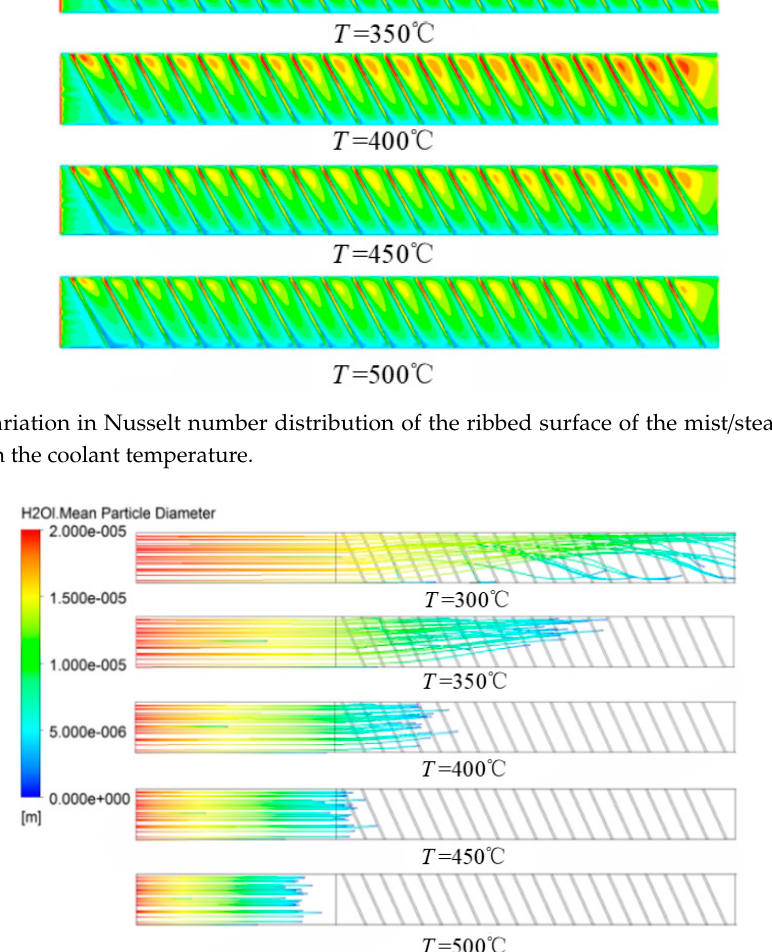
Figure 8. Variation in the droplet motion trajectory of the mist/steam cooling channel with the coolant temperature.